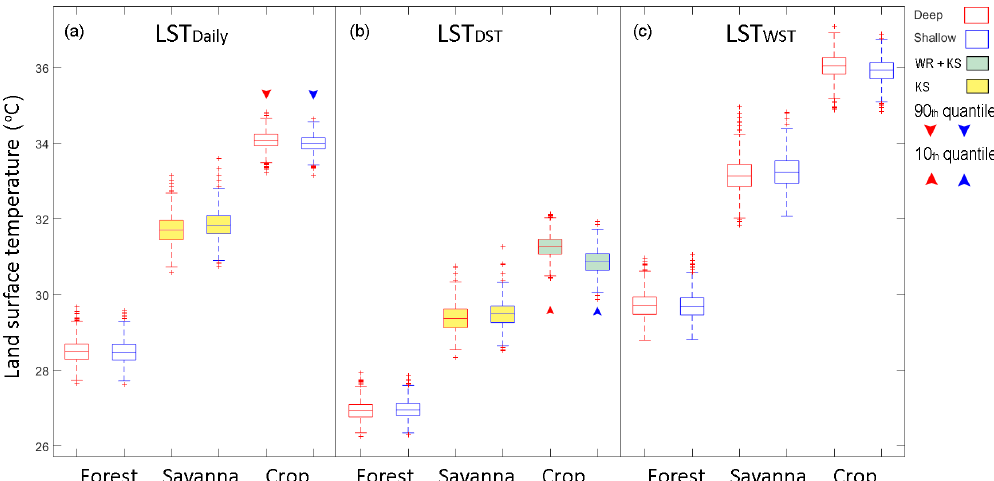
Figure 5. (a) Average daily land surface temperature (LST) annually LST daily , (b) during the dry season transition period LST DST , and (c) during the wet season transition LST WST . Red boxes represent deep WTD. Blue boxes represent shallow WTD. Yellow filled boxes represent a statistical difference in skewness, calculated by Kolmogorov–Smirnov, and green filled boxes represent statistical differences by both Wilcoxon rank and Kolmogorov–Smirnov. Significant differences in the 10th and 90th quantiles are depicted by the arrows.